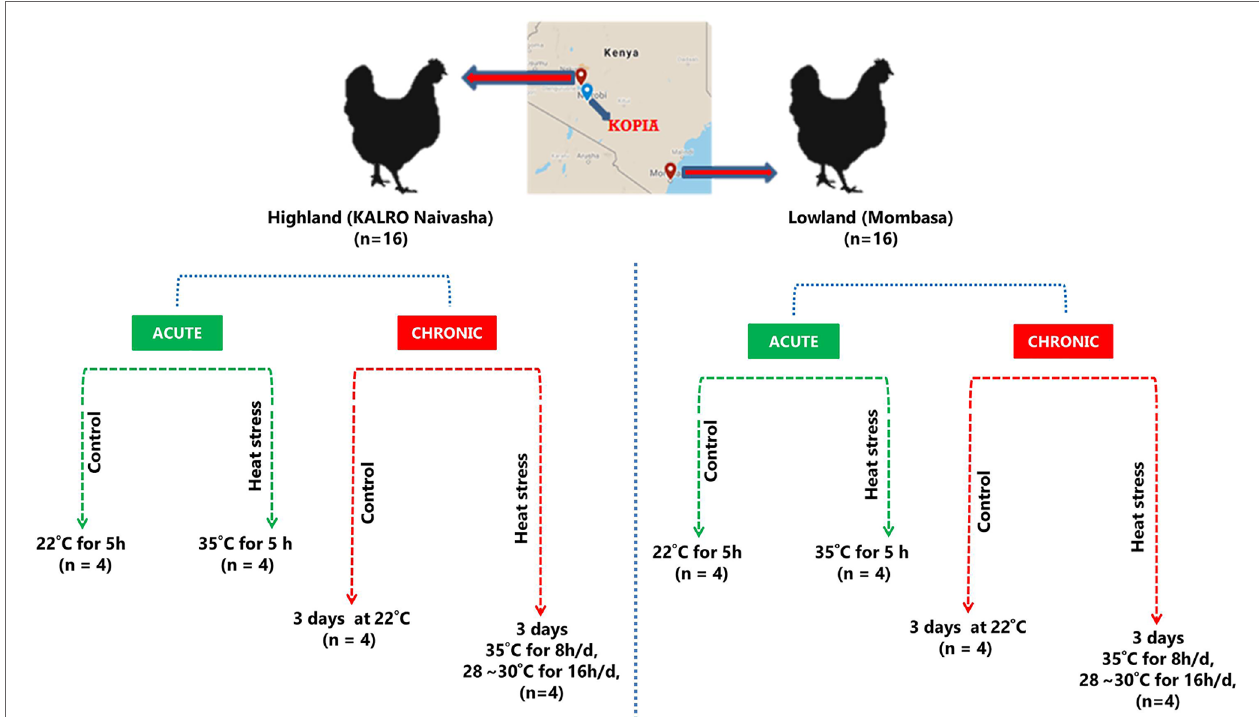
FIGURE 1 | Schematic experimental